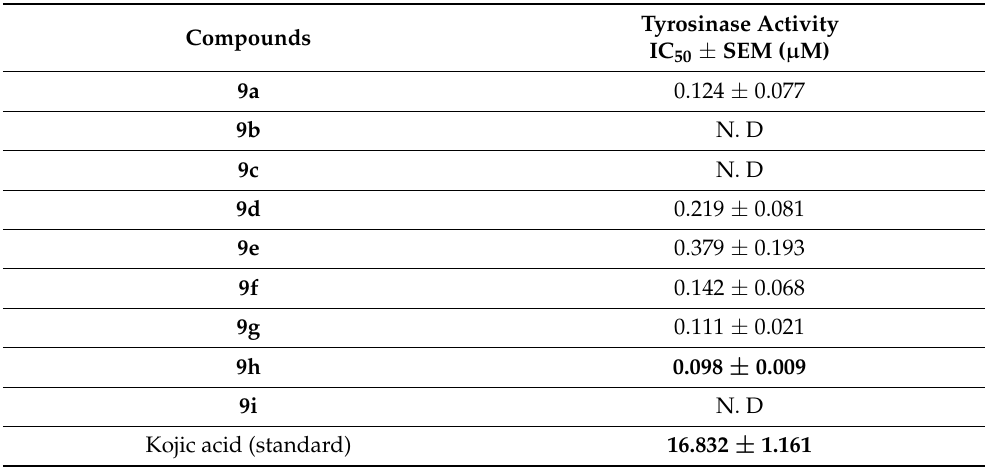
Table 1. Target compounds and IC 50 values for tyrosinase activity (SEM = standard error of the mean; values are expressed in mean ± SEM).